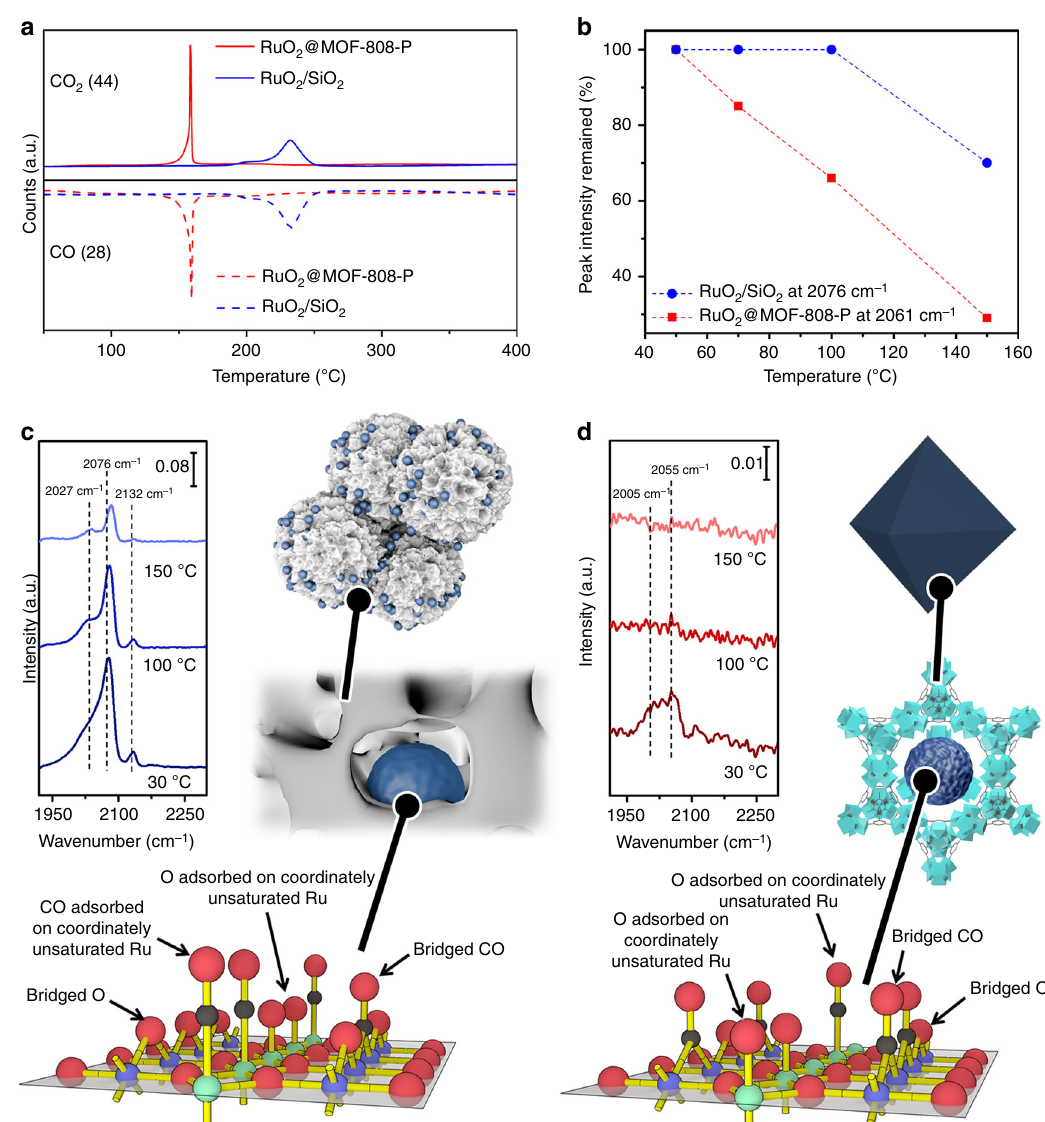
Fig. 3 CO and O interactions with RuO 2 for RuO 2 /SiO 2 and RuO 2 @MOF-808-P. a CO-temperature-programmed reduction (CO-TPR) in fl owing CO and b temperature-dependent diffuse re fl ectance infrared Fourier transform spectroscopy (DRIFTS) peak intensity reduction (due to CO desorption) for samples with only surface-adsorbed CO in fl owing Ar. DRIFTS results for c RuO 2 /SiO 2 and d RuO 2 @MOF-808-P with both surface-adsorbed CO and O in fl owing Ar at various temperatures. The RuO 2 (110) surface was taken as an example to assist our interpretation of the DRIFTS results in Table 1 (O in red, C in black, and green and blue for alternating rows of Ru with different {RuO 6 } octahedral orientation). Source data are provided as a Source Data fi